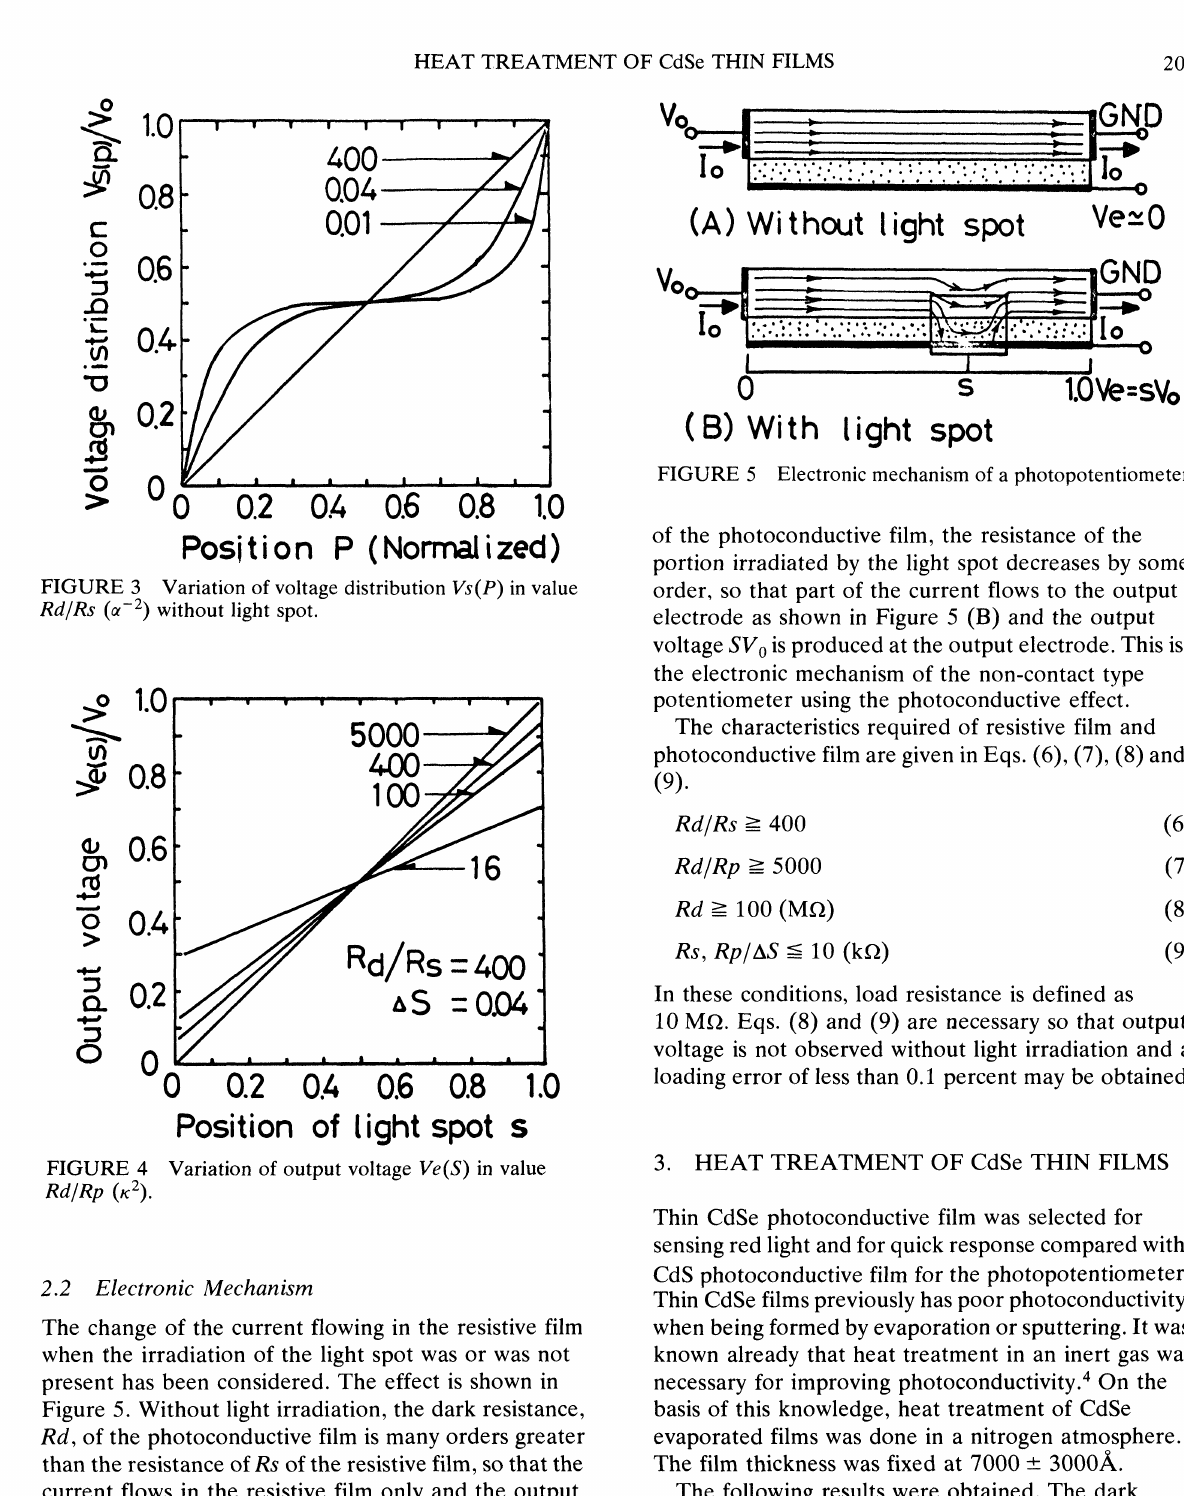
FIGURE 4 Variation of output voltage Ve(S) in value Rd/Rp